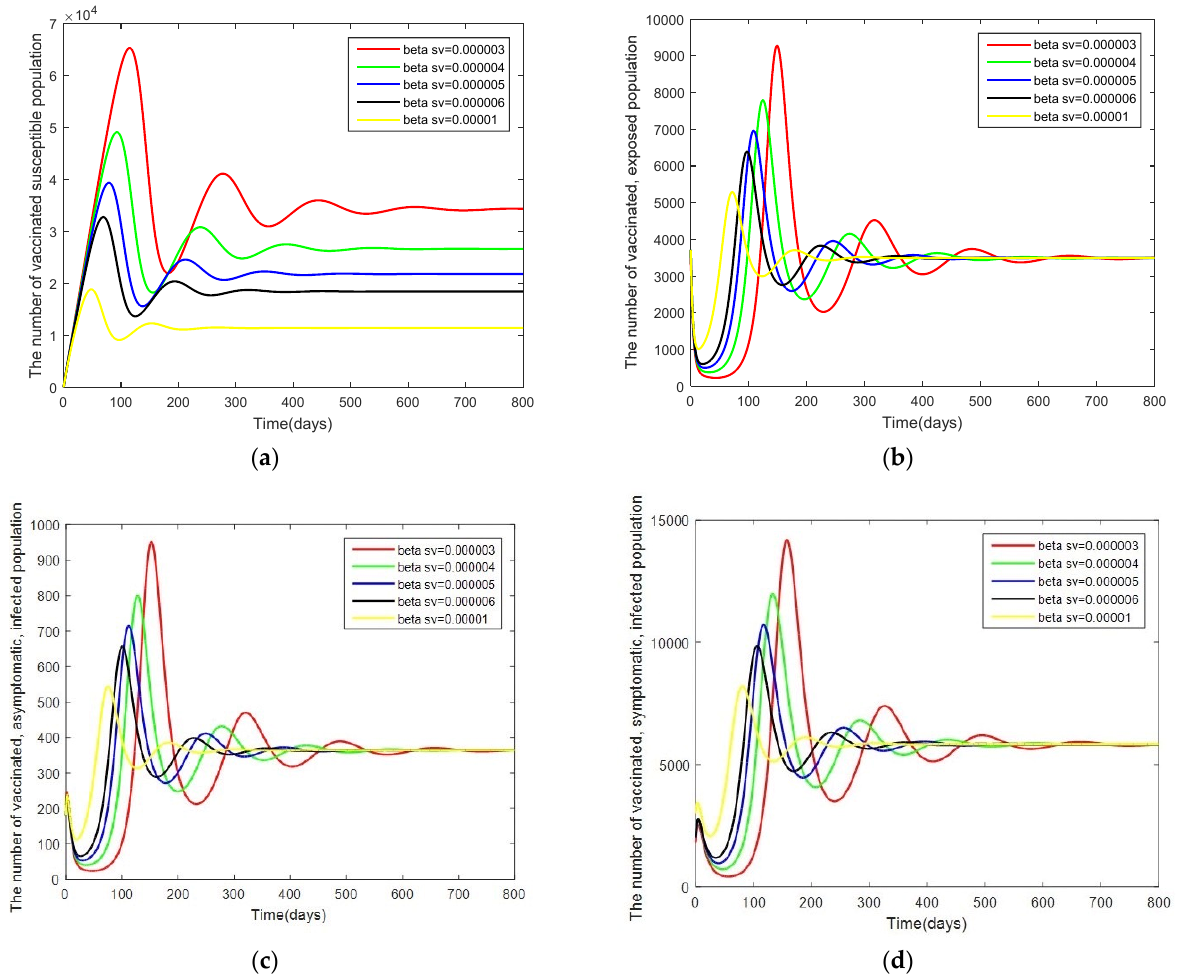
Figure 9. Graphs of the system of Equations (3)–(12) showing the comparison results of the infection rate of the symptomatic, vaccinated, infected population ( β sv ) when R 0 > 1: ( a ) the number in the vaccinated, susceptible population; ( b ) the number in the vaccinated, exposed population; ( c ) the number in the vaccinated, asymptomatic, infected population; and ( d ) the number in the vaccinated, symptomatic, infected population.